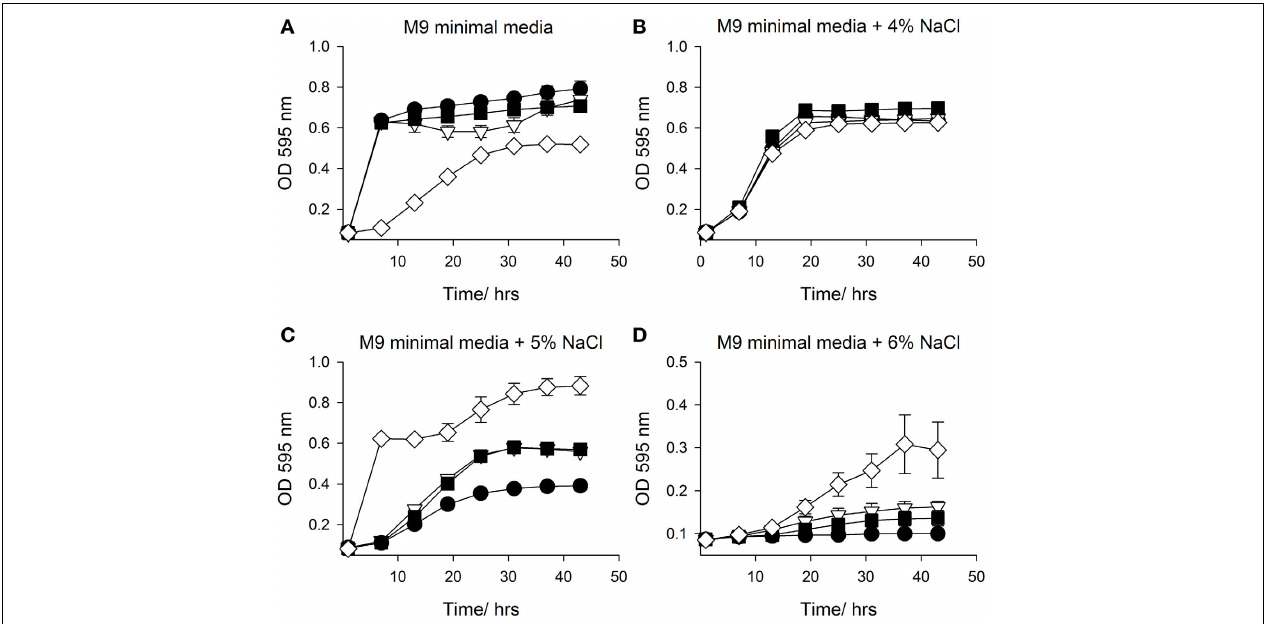
FIGURE 4 | Growth in M9minimal media with NaCl + / − 1mM L-carnitine. Growth of E. coli EPI300::pCC1FOS and SMG 9 in (A) M9minimal media, (B) M9minimal media + 4% NaCl, (C) M9minimal media + 5% NaCl and